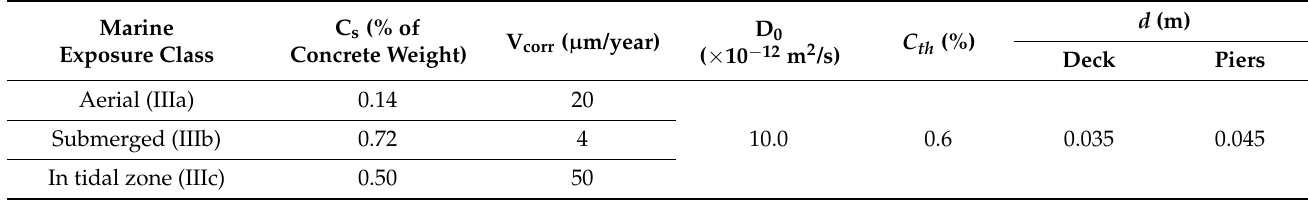
Table 2. Durability parameters for the Arosa